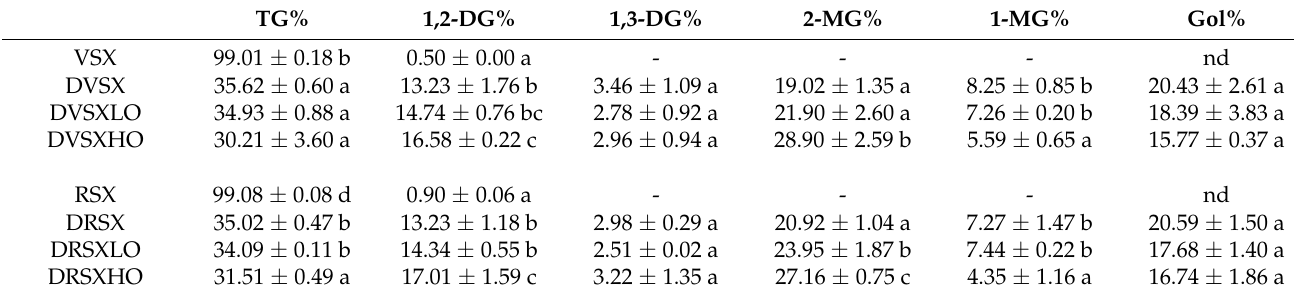
Table 1. Molar percentages of triglycerides (TG%), diglycerides (1,2-DG% and 1,3-DG%), monoglycerides (2-MG% and 1-MG%) and glycerol (Gol%) in relation to the total number of glyceryl structures present in the oxidized virgin and refined soybean oil samples (VSX and RSX) and in their digestates (DVSX and DRSX), as well as in the digestates of VSX and RSX samples mixed with two different levels of ovalbumin: 26% in weight (DVSXLO and DRSXLO) and 260% in weight (DVSXHO and DRSXHO). Different letters within each column indicate a significant difference among the samples corresponding to the same type of oil ( p <